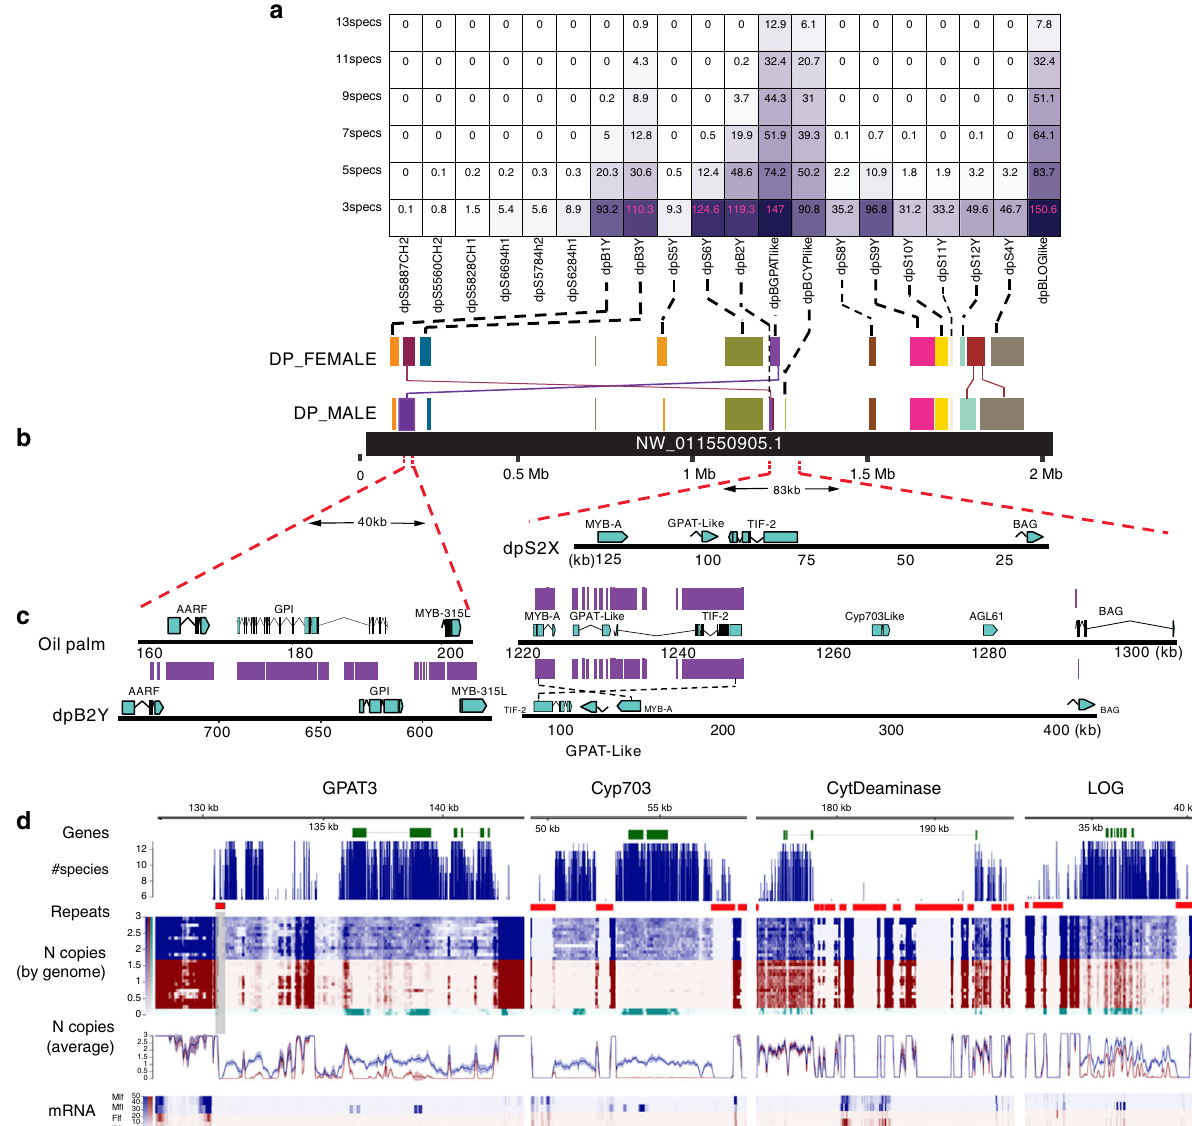
Fig. 3 The sex determination region in Phoenix . a Phoenix male-speci fi c kmers/bp in date palm scaffolds based on number of species compared (specs: species). Darker boxes indicate higher densities of kmers/bp. Scaffolds with male-speci fi c kmers had similarity to a single locus in oil palm. The only gene not deriving from the region was LOG-like. b Sequencing of representatives of both male (DP_MALE) and female (DP_FEMALE) alleles in date palm showed coverage of signi fi cant sections of the oil palm scaffold NW_011550905.1. Each date palm scaffold is connected by a dotted line to a colored rectangle showing span of similarity with oil palm. c Comparison of the date palm X and Y alleles to the orthologous oil palm region revealed a deletion of the GPAT3 and CYP703 gene in the X chromosome. A similar GPAT3 deletion is found in the Y chromosome although the GPAT3 gene does exist elsewhere on Y. The region showed a fusion/inversion (red dotted lines) with respect to the oil palm locus joining the region downstream of MYB315L to the region upstream of BAG-like in date palm. Note shift of sequence coordinates in dpB2Y with respect to oil palm reveals inversion. Cytidine deaminase resides in this region in oil palm. d Analysis of male-speci fi c kmers present in all species of Phoenix identi fi ed only four scaffolds dpBGPATlike containing GPAT3, dpBCYPlike containing CYP703, dpB3Y containing cytidine deaminase like (CytDeaminase), and dpBLOGlike containing LOG. The most widely conserved kmers were focused in gene and apparently gene regulatory regions (#species track). Sequence coverage of each genome was normalized to 2N and plotted as a heatmap. Blue rows represent males; red rows represent females from the various Phoenix species. Green rows represent hermaphrodite palms Brahea and Livistona. Males showed one copy and hermaphrodite palms showed two copies per genome in most exonic regions ( N copies, by genome track) with some variation (see text). The average coverage for all males indicated these regions were likely at 1 N except for the LOG gene that has an autosomal paralog and cytidine deaminase that has an X-linked copy ( N copies, average track). Gene expression (mRNA track) showed that GPAT3, CYP703, and LOG were all expressed in male fl ower (M fl ) and was either very low or undetectable in male leaf (Mlf), female fl ower (F fl ), and female leaf